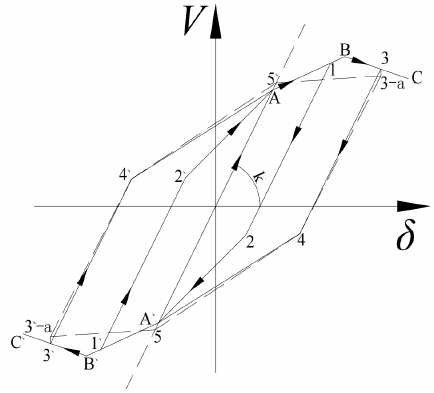
Figure 25. The SRFM for distortional instability failure.